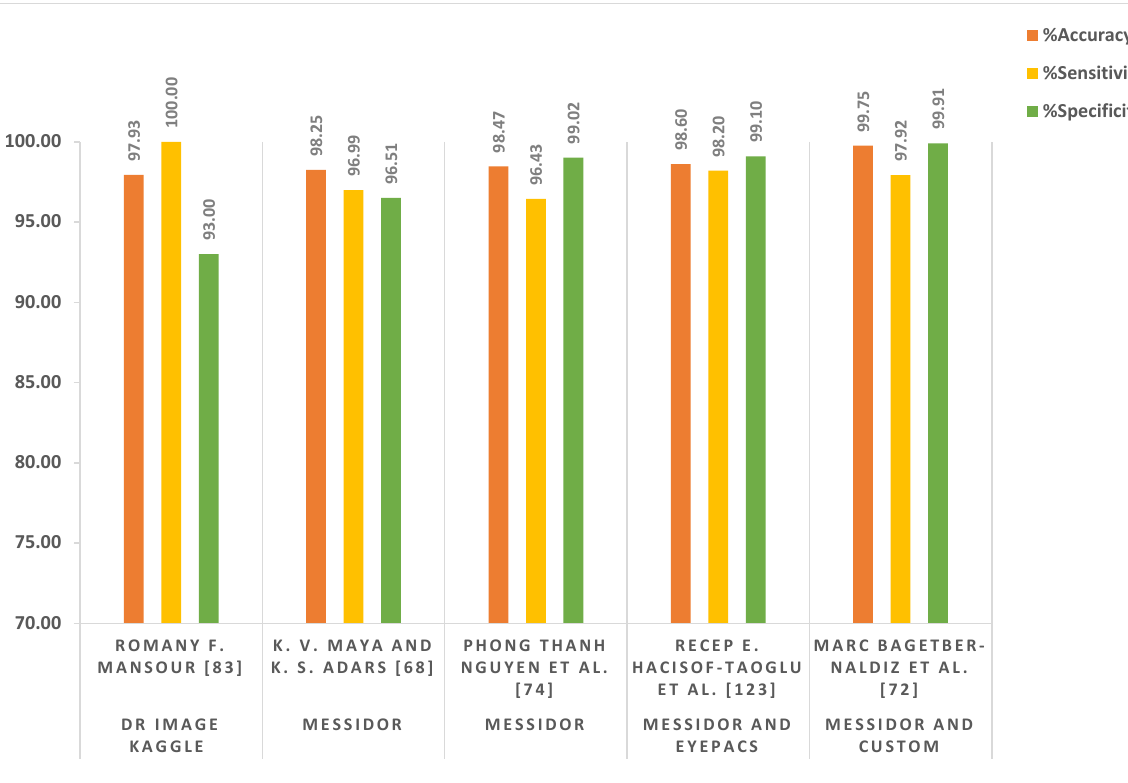
Figure 5. Top 5 publications reporting the best performance for the prediction.